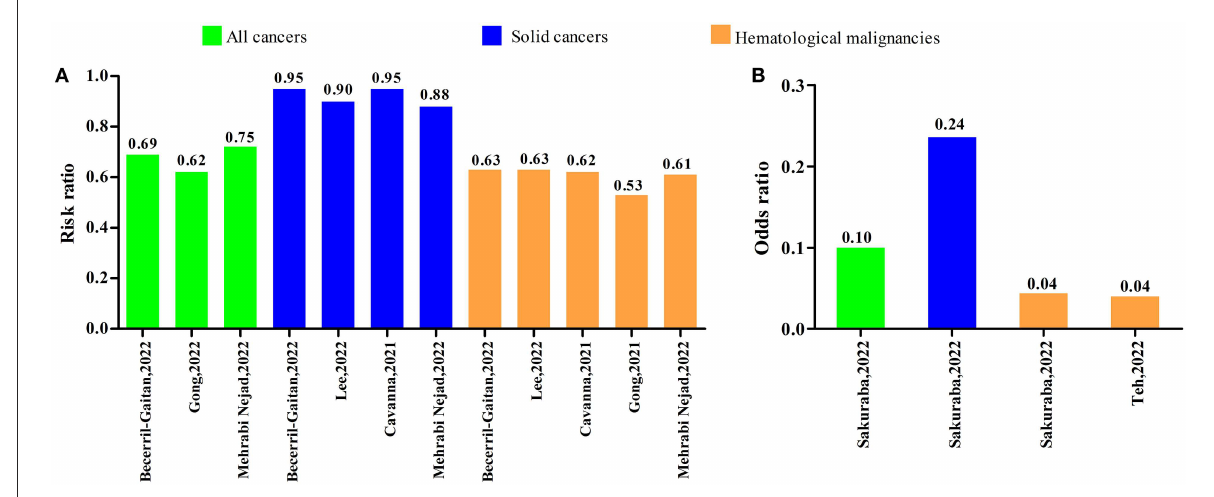
FIGURE7 Serologic response after the second dose of COVID-19 vaccine compared to controls. (A) Risk ratio (B) Odds ratio.